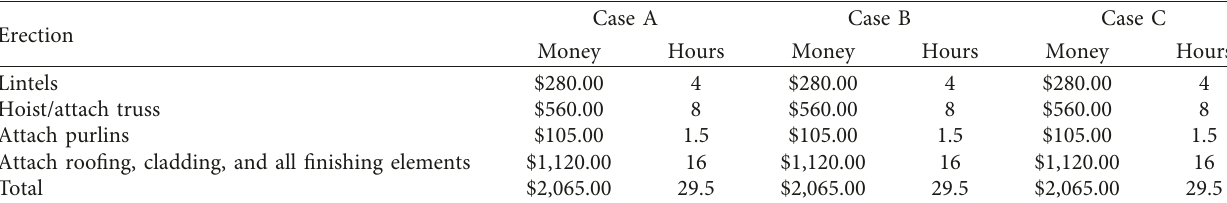
Table 7: Summary of truss labour.